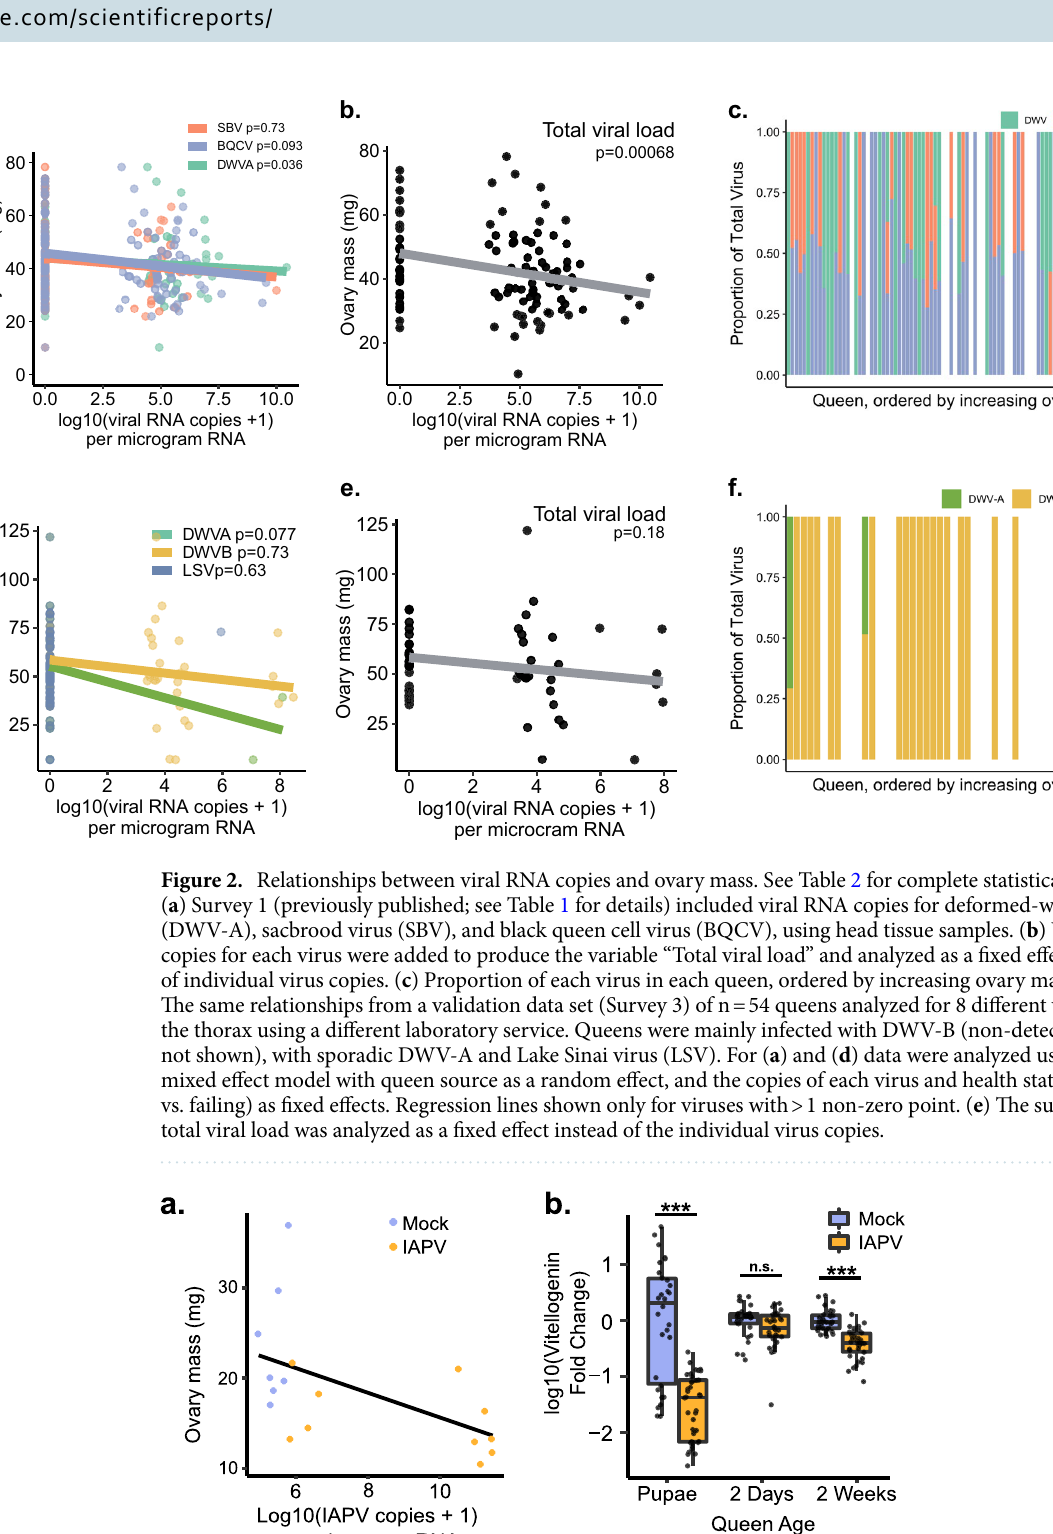
Figure 3. Ovary mass and vitellogenin transcription are significantly decreased after IAPV injection. ( a ) Mated, age-matched queens were injected with IAPV or a mock (buffer only; n = 10 each). After 65 h the ovary mass of infected queens was significantly reduced. Data was modeled using a simple linear model, p = 0.024. ( b ) The transcript for vitellogenin is downregulated in the abdomens of queens experimentally infected with IAPV at two days before emergence and two weeks post-emergence (after CO 2 ovary activation). The fold-change in gene expression was calculated using the 2 −∆∆Ct method. Pairwise comparisons of gene expression were evaluated using the Wilcoxon Rank Sum test (n.s. = not significant, *** p <